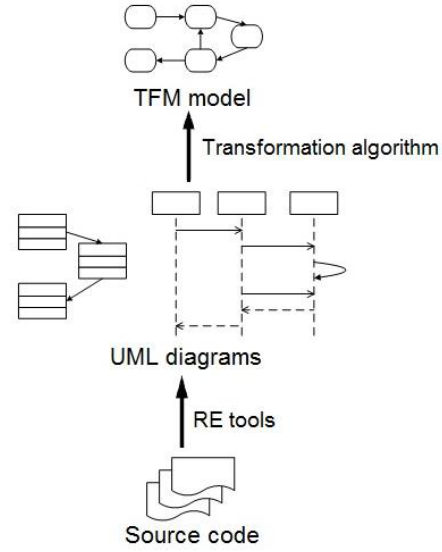
Fig. 2. The process of obtaining the